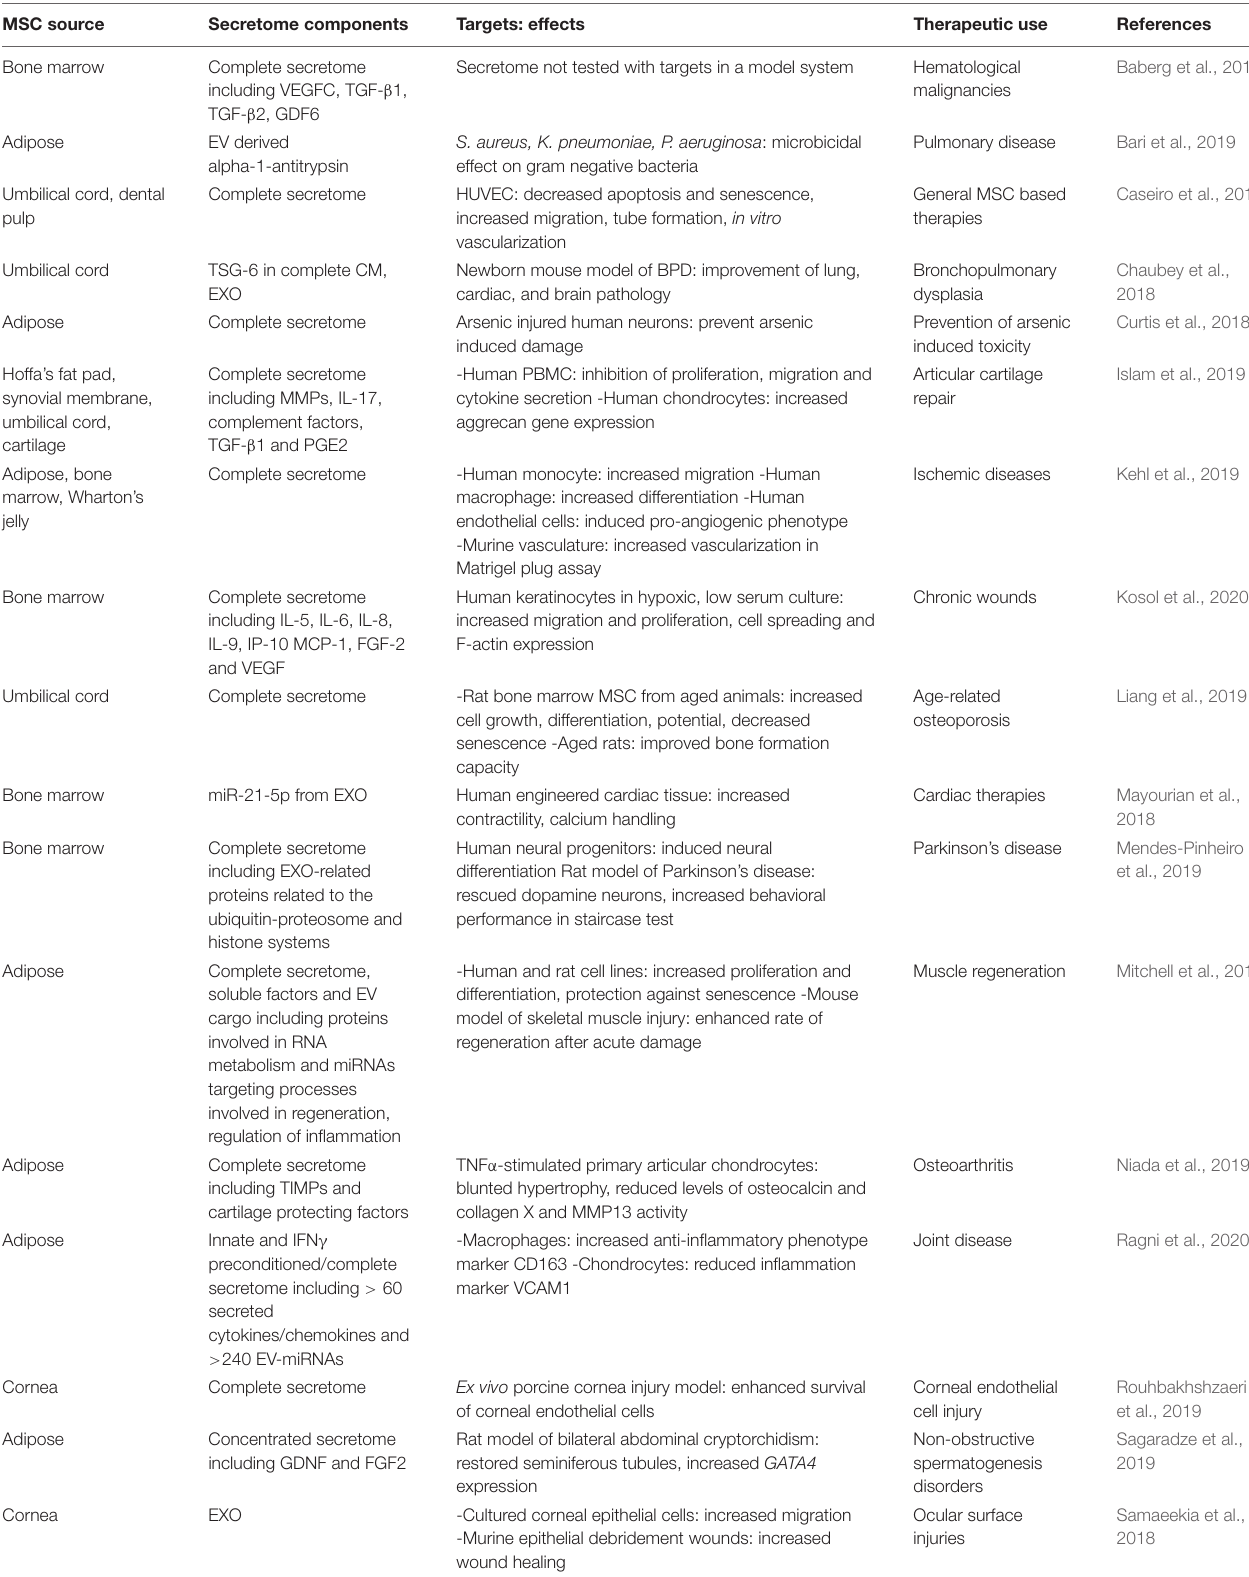
TABLE 1 | Human MSC secretome components, targets, effects, and potential therapeutic